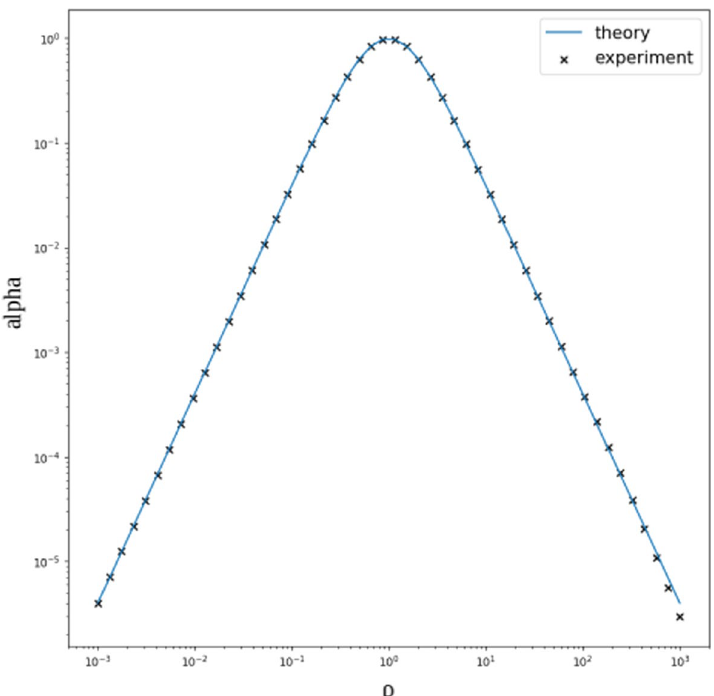
Fig. 5 Illustration of the numerical errors arising from batch normalization layers. Comparison of the theoretical and empirical evolution of the α ratio for different ρ values in our toy example. Empirical values were computed for a Gaussian input signal with zero mean and standard deviation 1 and a white Gaussian noise of standard deviation 10 −